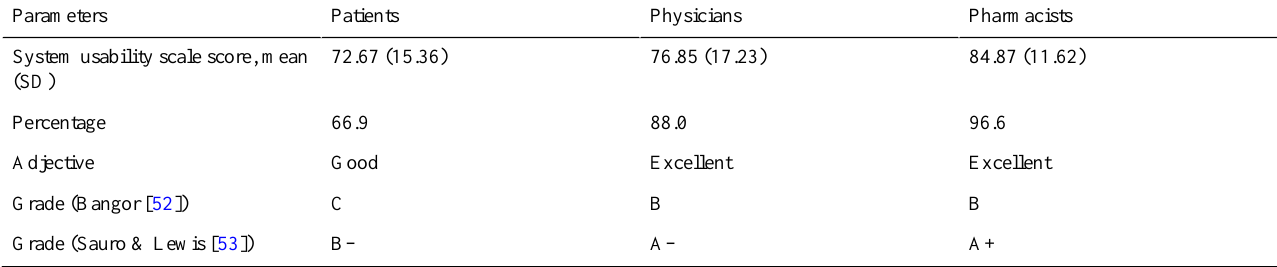
Table 3. Transformation of TMED system usability scale scores into percentile ranks, adjectives, and grades for patients, physicians, and pharmacists.